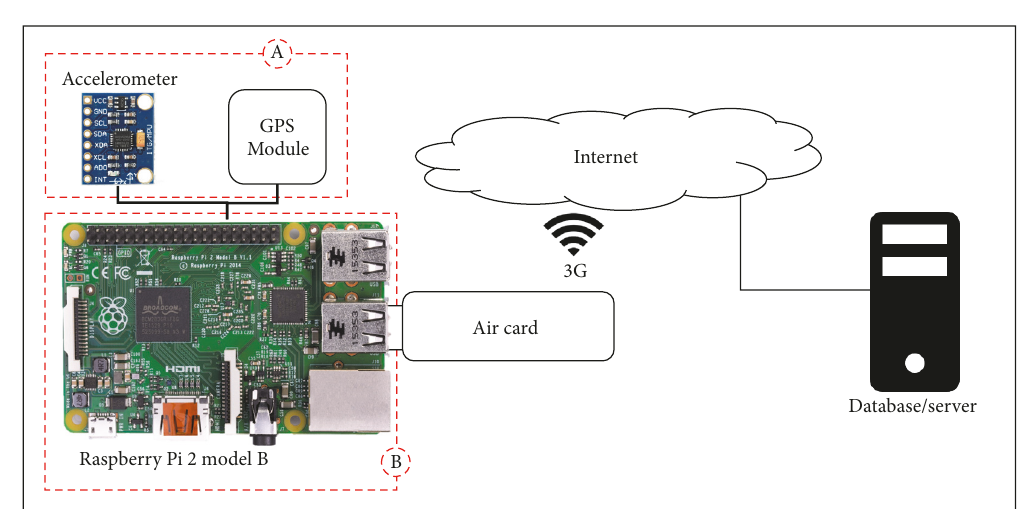
Figure 3: System architecture.